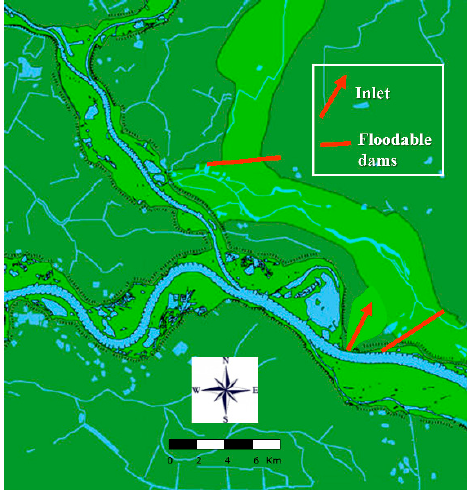
Figure 8. Retention polder in Rijnstrangen area (copyright [10]).